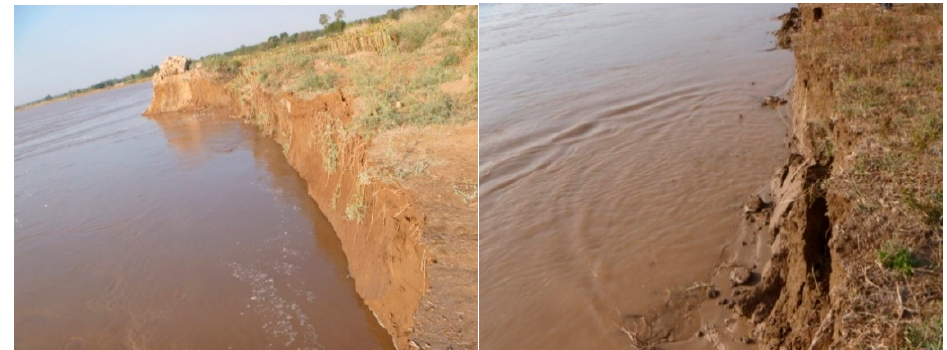
Figure 3. Example of the existing bank slope ( left ) and an example of riverbank collapse along Dengkou